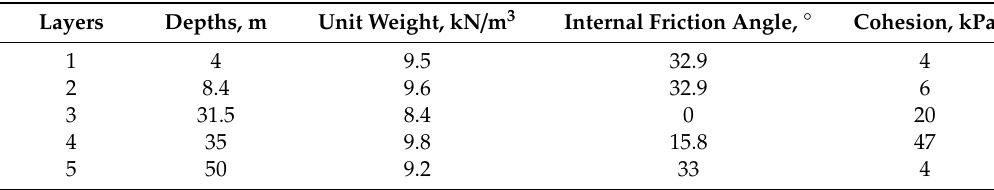
Figure 3. Finite element model. Table 1. Soil parameters.